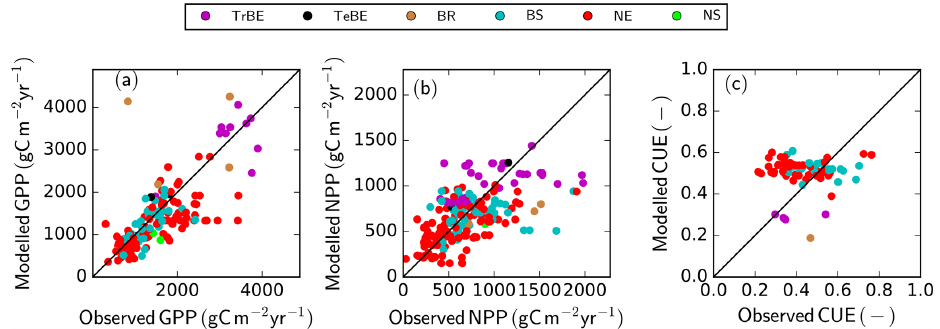
Figure 6. Simulated versus observed GPP (a) , NPP (b) , and carbon use efficiency (CUE = NPP / GPP) (c) at GFDB sites against observa- tions. For PFT abbreviations, see Table 1. Note that observations of GPP and NPP are not consistently available for all sites. Table 3. The 10 most important parameters (P) determining model uncertainty at four FLUXNET sites (FI-Hyy, FR-Hes, AU-Tum, and BR- Ma2, as in Figs. 3 and 8) and reference to the respective parameter description table in the Supplement (T). Overall importance of parameters is measured by first calculating the RPCC for each output variable and then calculating the mean of the absolute RPCC values across GPP, net N / P mineralisation, vegetation, and ecosystem C, as well as leaf C : N : P, weighted by the uncertainty contribution of these model outputs. The parameter names are denoted by asterisks: ∗ refers to photosynthesis-related parameters; ∗∗ to soil-biogeochemistry-related parameters; ∗∗∗ to parameters related to vegetation growth and dynamics. See also Table S9 for a detailed breakdown of RPCCs according to output